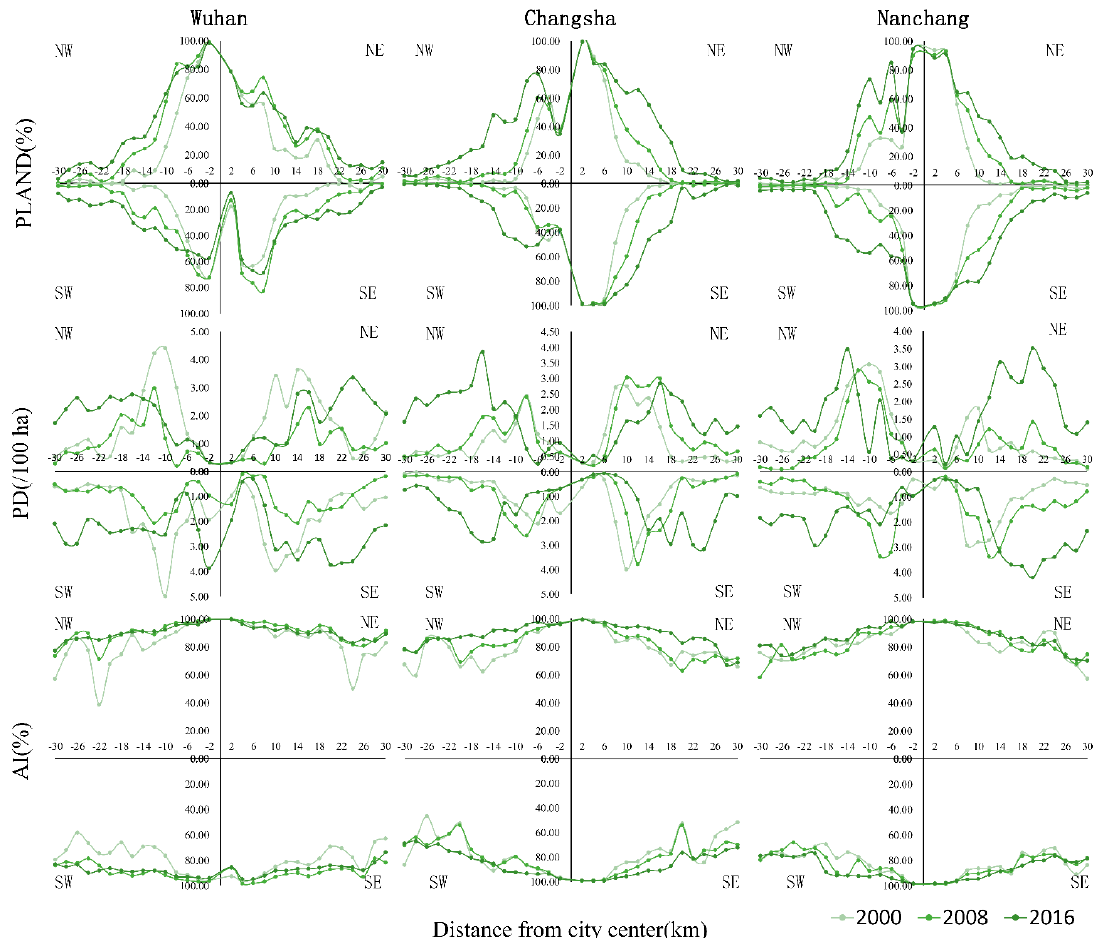
Figure 11. Landscape metrics for the urban land area of Wuhan, Changsha and Nanchang at different distances (km) from the city center from 2000 to 2016.